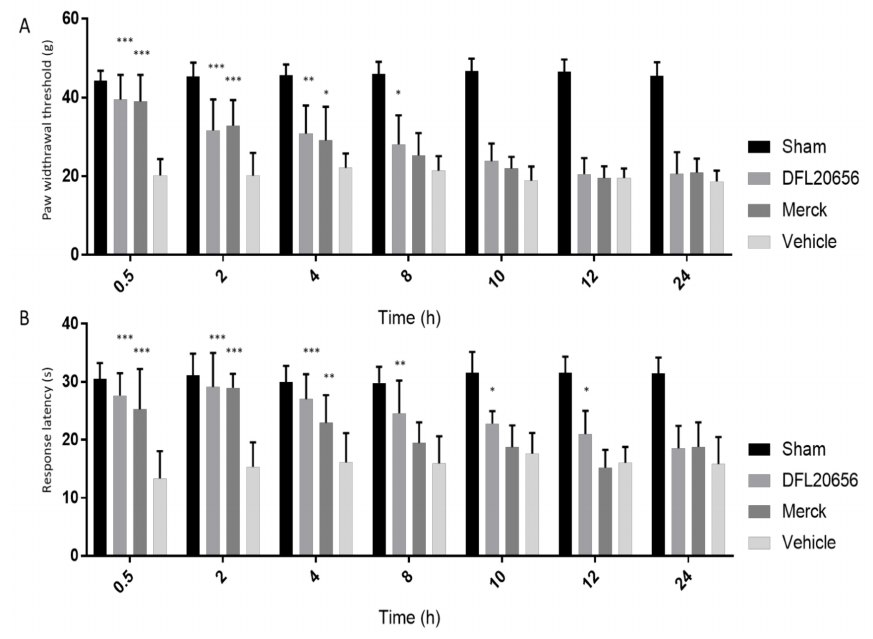
Figure 7. Antiallodynic e ff ect of DFL20656 and Merck compound 14 after intravenous administration in a model of neuropathic pain. The e ffi cacy of DFL20656 and the Merck compound were evaluated in a CCI rat model. Both mechanical allodynia ( A ) and thermal hyperalgesia ( B ) were evaluated. The DFL20656 showed a significant e ff ect in reducing mechanical allodynia up to 8 h following intravenous administration, while Merck compound was active up to 4 h. For thermal hyperalgesia DFL20656 was active up to 12 h following administration, while Merck compound did not display significant e ffi cacy after 4 h. The data represent the mean of 10 rats per experimental group. All data were presented as the mean ± SEM. Bonferroni-Dunn post hoc test was used. p < 0.05 was considered representative of significant di ff erences. *** p < 0.001, ** p < 0.01 and * p < 0.05 vs CTR